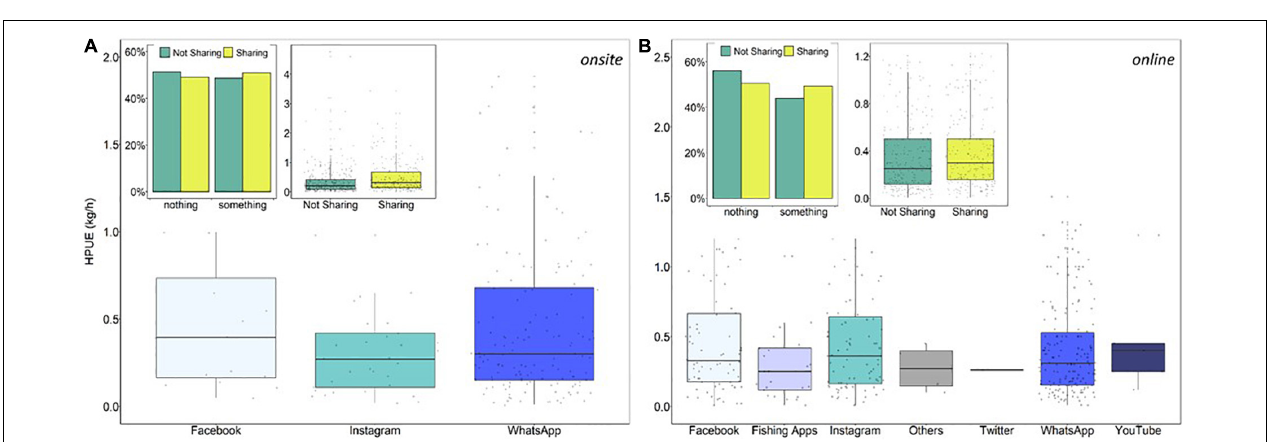
FIGURE 7 | Barplots describing the percentage of fishers that harvested something (“something”) or did not harvest (“nothing”) according to the sharing activity [left inlet for both onsite (A) and online (B) surveys]. Boxplots represent kg of fish harvested per hour (HPUE) for sharers and non-sharers (inlet to the right), and according to the type of digital platform used to share (main plot). In the onsite survey (A) , the percentage of fishers that harvested something was 49% for sharers and 51% non-sharers, while for those that did not harvest was 51% for sharers and 49% for non-sharers. Recreational fishers that caught something showed that average HPUE for sharers was 0.5 kg/h, while for non-sharers was 0.4 kg/h. In the online questionnaire (B) , the percentage of fishers that harvested something was 49% for sharers and 44% non-sharers, while for those that did not harvest was 51% for sharers and 56% for non-sharers. Recreational fishers that caught something showed that average HPUE for sharers was 0.4 kg/h, while for non-sharers was 0.3 kg/h. Boxplots represent the median (bold centreline), the 25th (top of the box) and 75th percentile (bottom of the